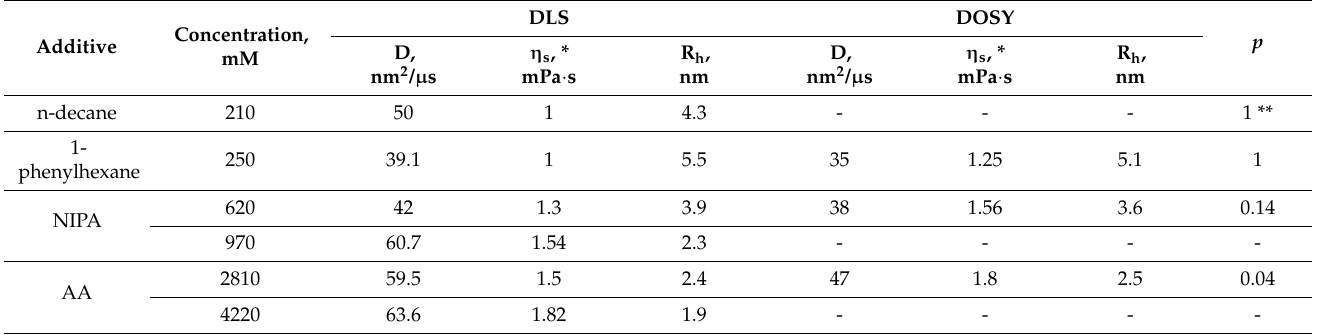
Table 3. Approximate additive concentrations (mM) corresponding to different ranges of viscosity drop in Figure